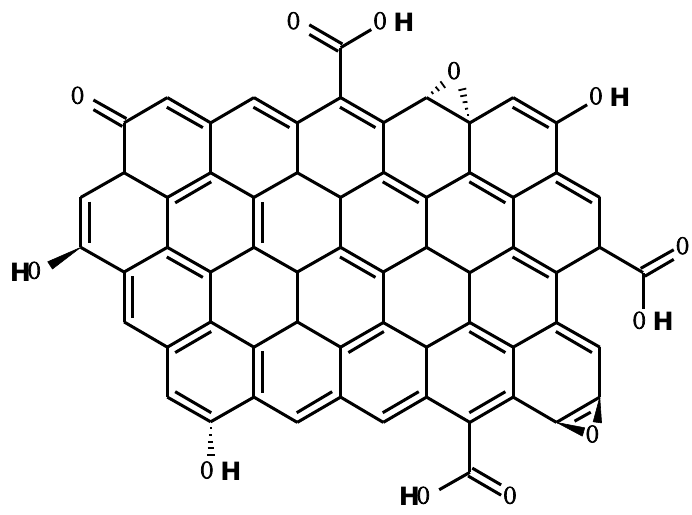
Figure 1. Chemical structure of reduced graphene oxide (rGO).